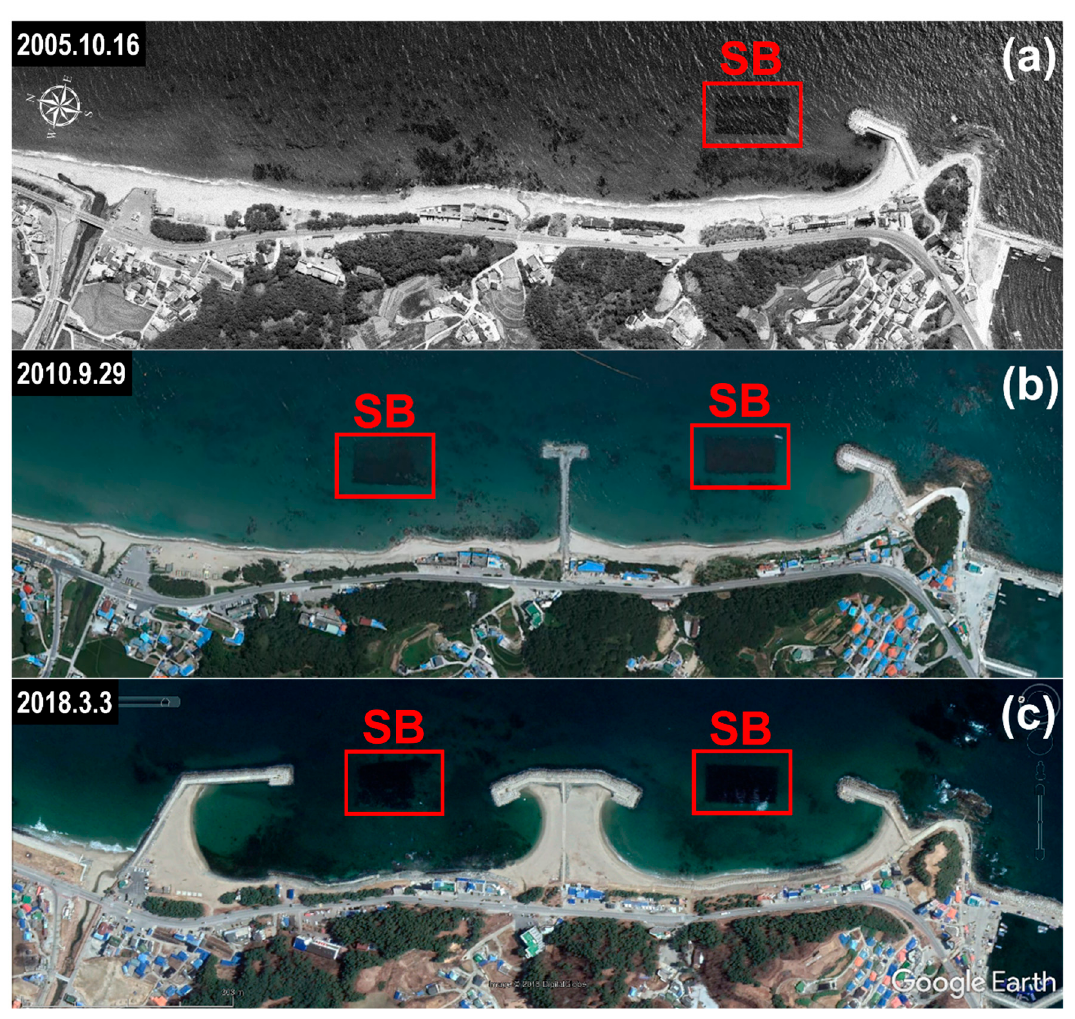
Figure 3. ( a ) Aerial photo of the area near the HB and SB shown in Figure 1b, taken on 16 October 2005 and ( b ) 29 September 2010; ( c ) Google Earth image of the same site, taken on 3 March 2018.